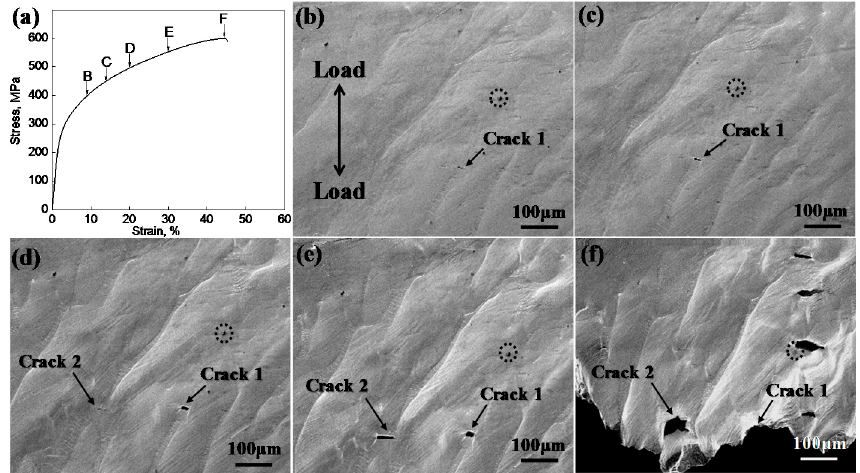
Figure 4. ( a ) In situ observation at different stages for strains ( b ) ε = 9%; ( c ) 14%; ( d ) 20%; ( e ) 30%; and ( f ) rupture of CDSS thermally aged at 400 °C for 20,000 h. An inclusion is marked by a dashed circle as the position mark.